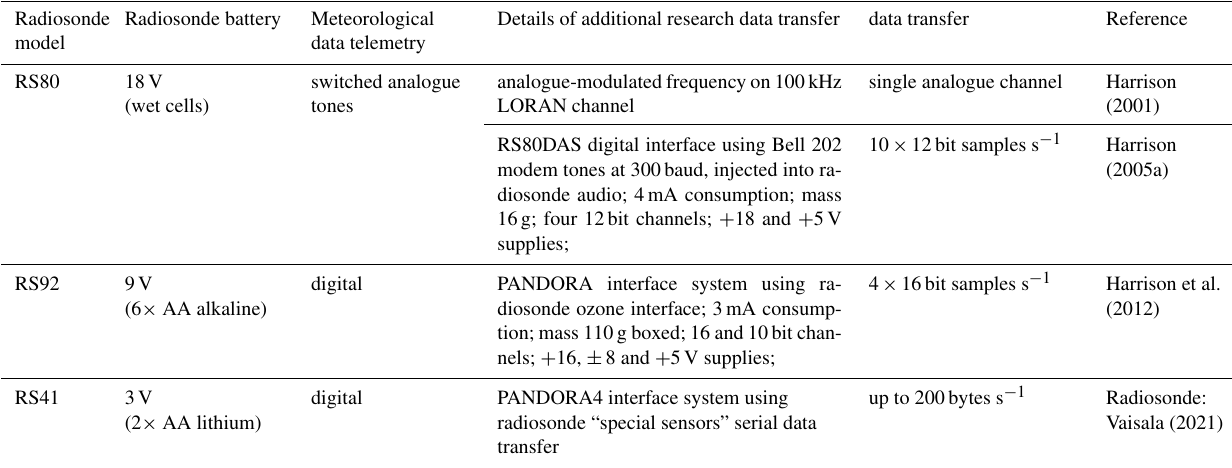
Table 1. Vaisala meteorological radiosondes and their use with additional research